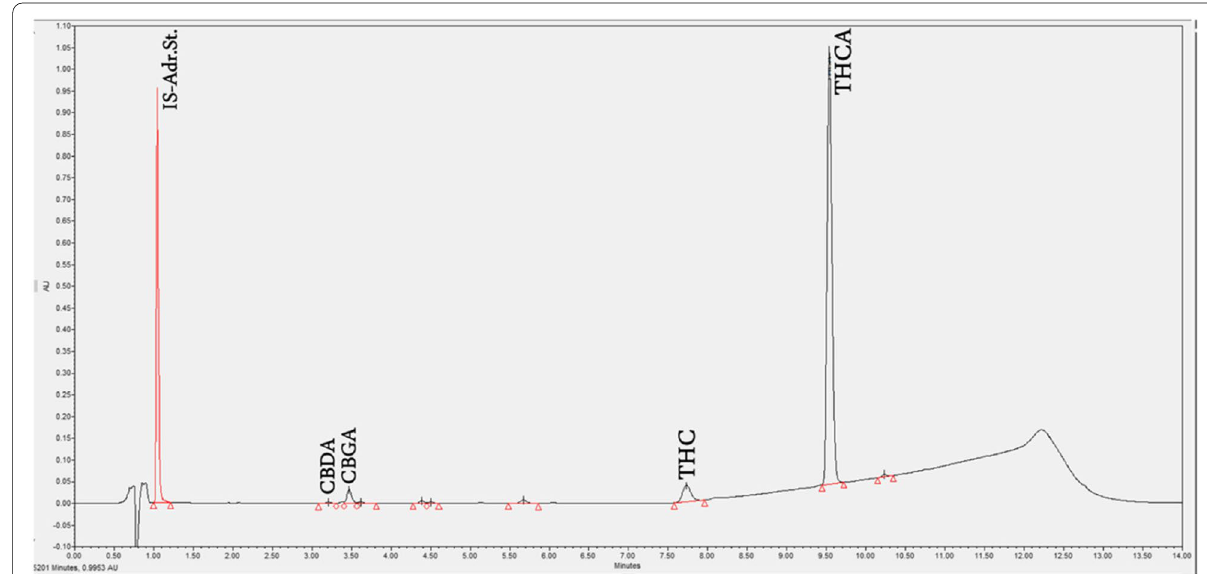
Fig. 1 U-HPLC analysis of the Bedrocan MC inflorescence product. From left to right, the analyzed phytocannabinoids were CBDA, CBGA, THC, and THCA. CBN and CBG are undetectable in a fresh specimen. CBDA, cannabidiol acid; CBGA, cannabigerolic acid; THC, (-)-∆ 9 -trans- tetrahydrocannabinol; THCA, (-)-∆ 9 -trans- tetrahydrocannabinol acid; CBN, cannabinol; CBG,